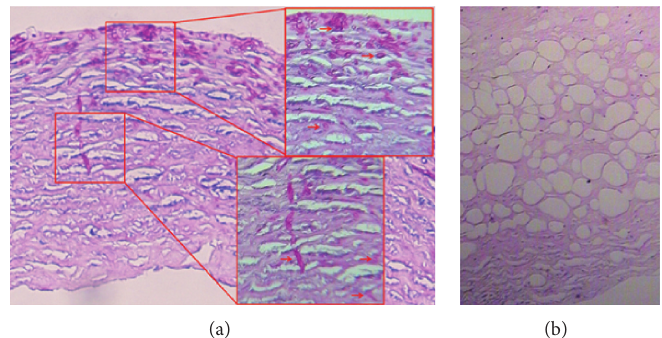
Figure 2: The density of the hyphae and spores (arrows) is much higher in the anterior stroma than that in the posterior stroma (a), × 100. The posterior stroma is loosened due to the air injection, and the hyphae and spores are not seen in the stroma near the Descemet membrane (b), ×